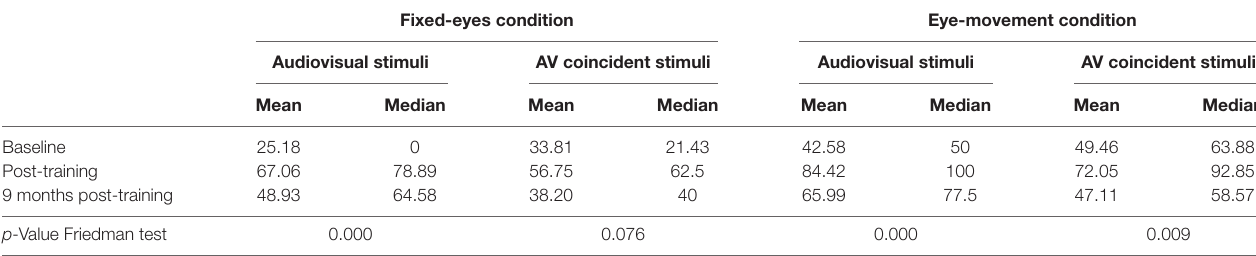
tABle 3 | Subject 3: bimodal audiovisual